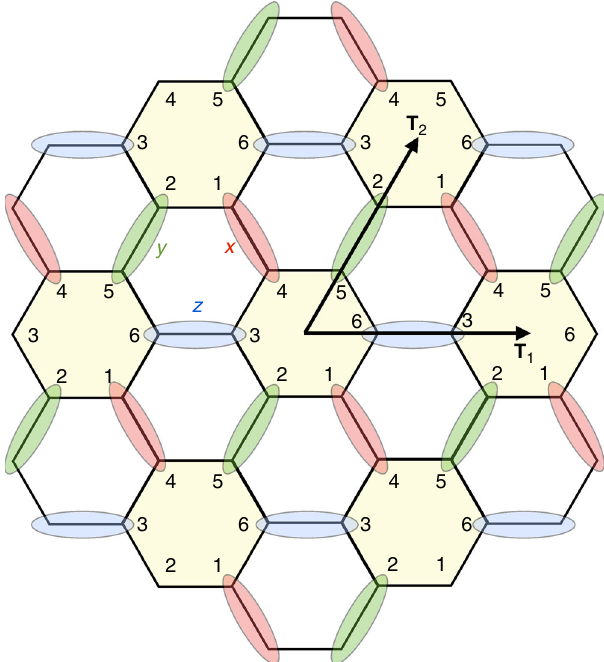
Fig. 8 Six sublattice decomposition of the lattice corresponding to the star dimer pattern of Fig. 2. Each unit cell of the superlattice contains six spins, labeled by the numbers 1 – 6. The two black arrows show two primitive translations, T 1 and T 2 , of this superlattice